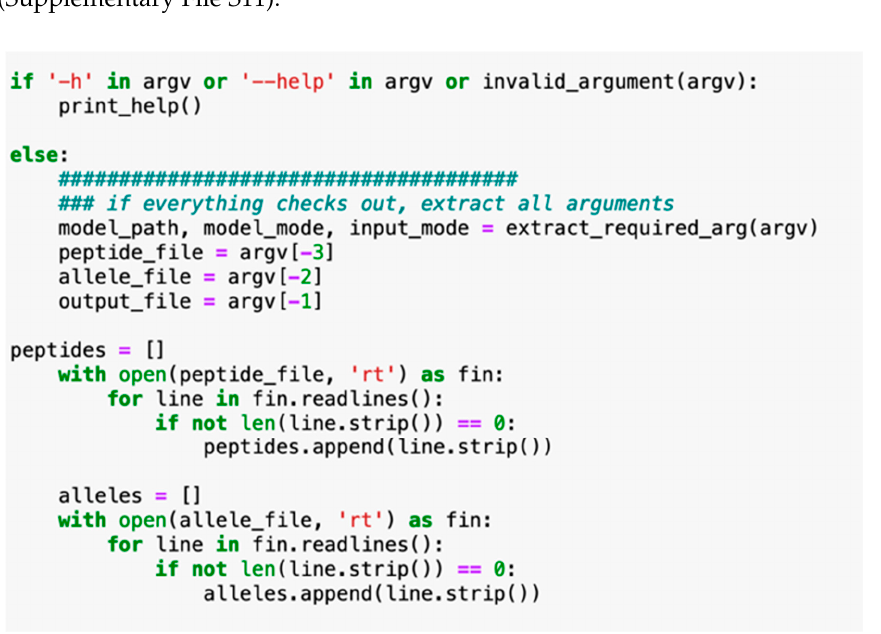
Figure 4. IntegralVac used the code for retraining to support the input of multiple peptide lengths and types, as opposed to Swiss-Prot database proteins and peptides of amino acid length 9 [8]. We instead used peptides of lengths 7–9 depending on the dataset.